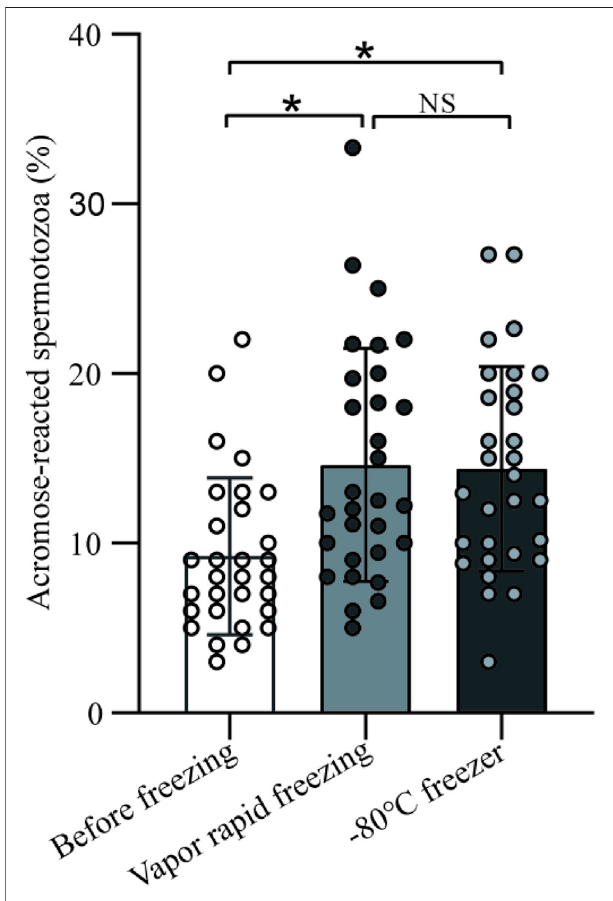
FIGURE 4 | The impact on sperm acrosome of vapor rapid freezing and − 80 ° C freezer. Sperm treated by freezing had signi fi cant higher acrosome reaction than before freezing ( p -value < 0.05). There was no signi fi cant difference in the acrosome reaction between vapor rapid freezing and − 80 ° C freezer ( p -value > 0.05).